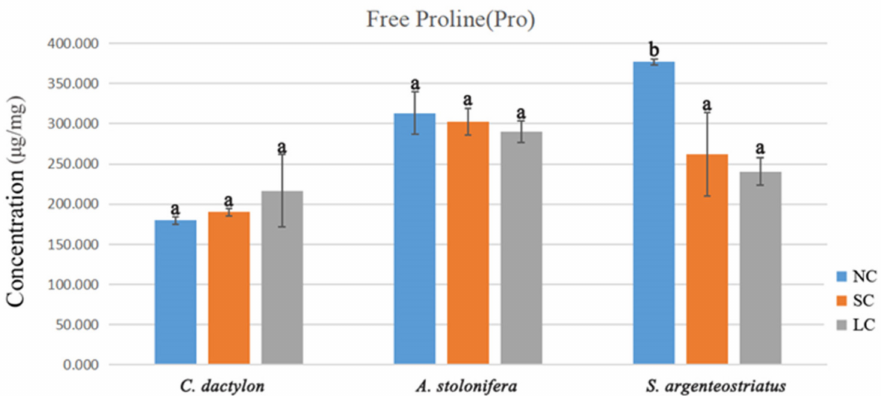
Figure 8. Graph of free proline concentrations. Note: Different normal letters indicate significant differences among treatments ( p <